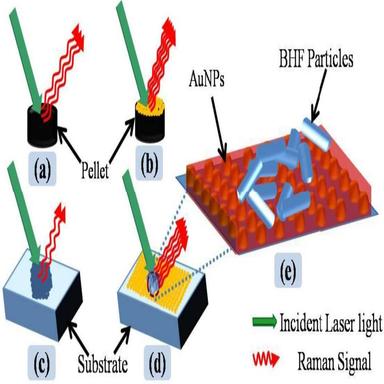
Schematic of experiment for normal (a,c) and SERS (b, d) signal recording. (e) Enlarged view of the BHF particles on the sea of Hotspots.